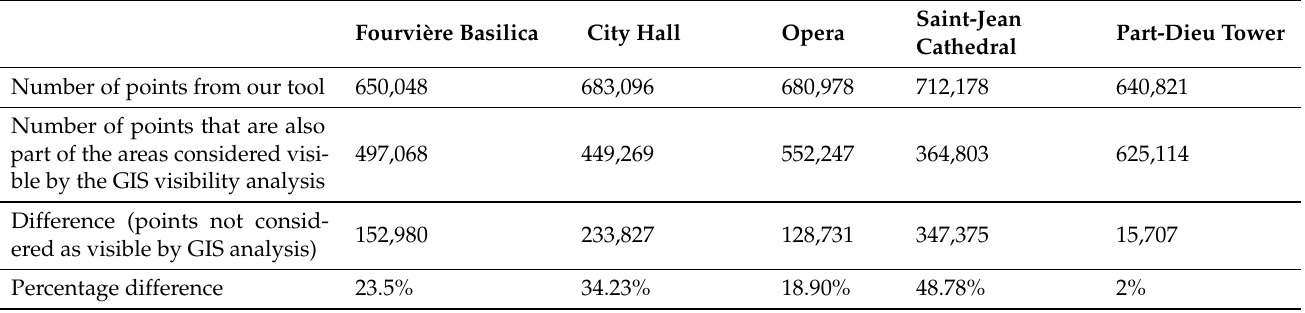
Table 4. Results from the comparison between our analysis with 1 m buffer and a raster analysis from different landmarks in the Lyon